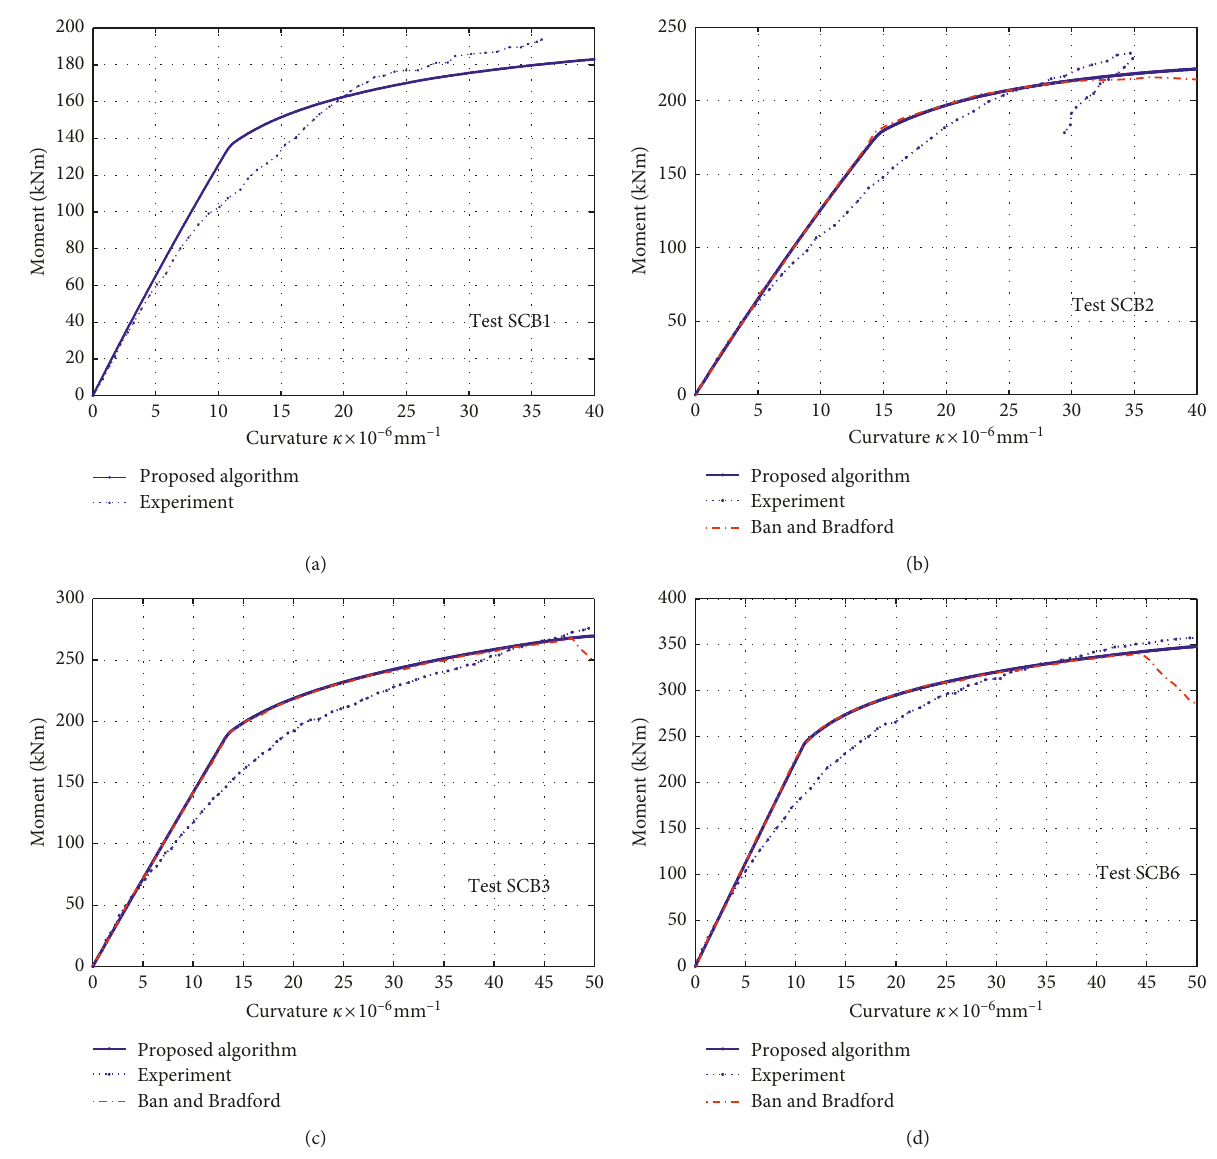
Figure 7: Moment-curvature relations for tests by Zhao and Yuan [11].